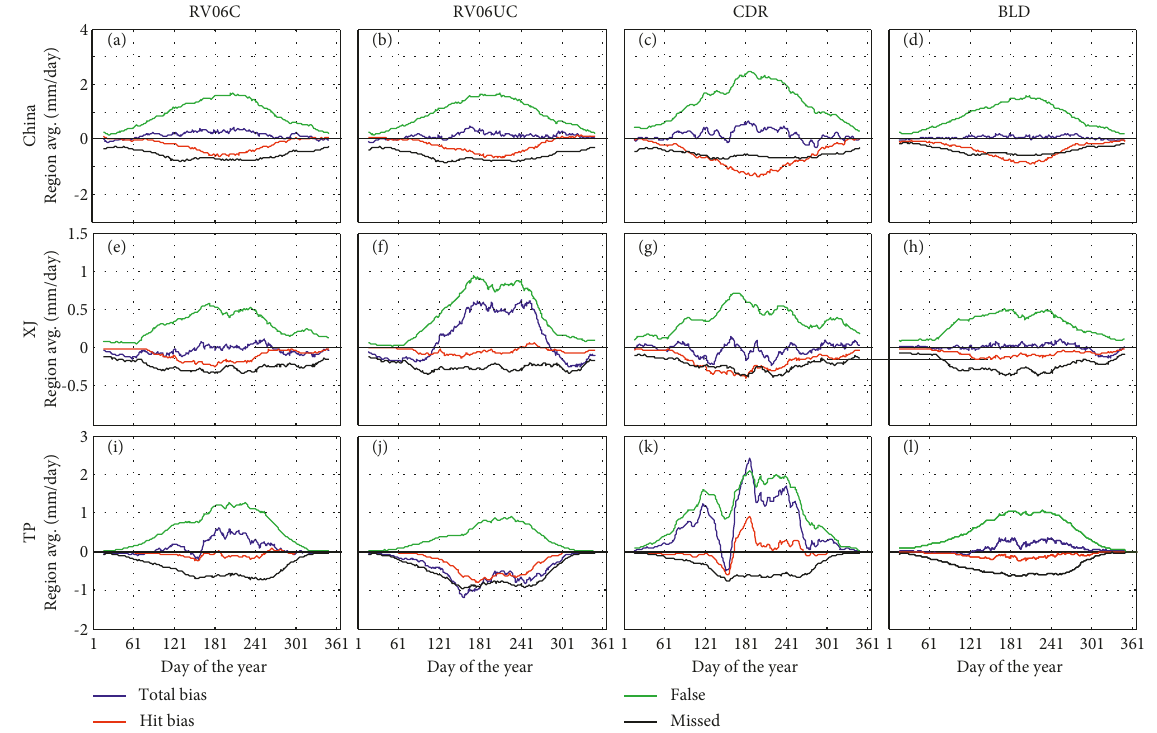
Figure 9: Regionally averaged time series of the total bias and error components for RV06C, RV06UC, CDR, and BLD during the study period from March 2014 to June 2018 over Mainland China and XJ and TP subregions. A 31-day moving average is utilized to each average daily precipitation time series to reduce visual